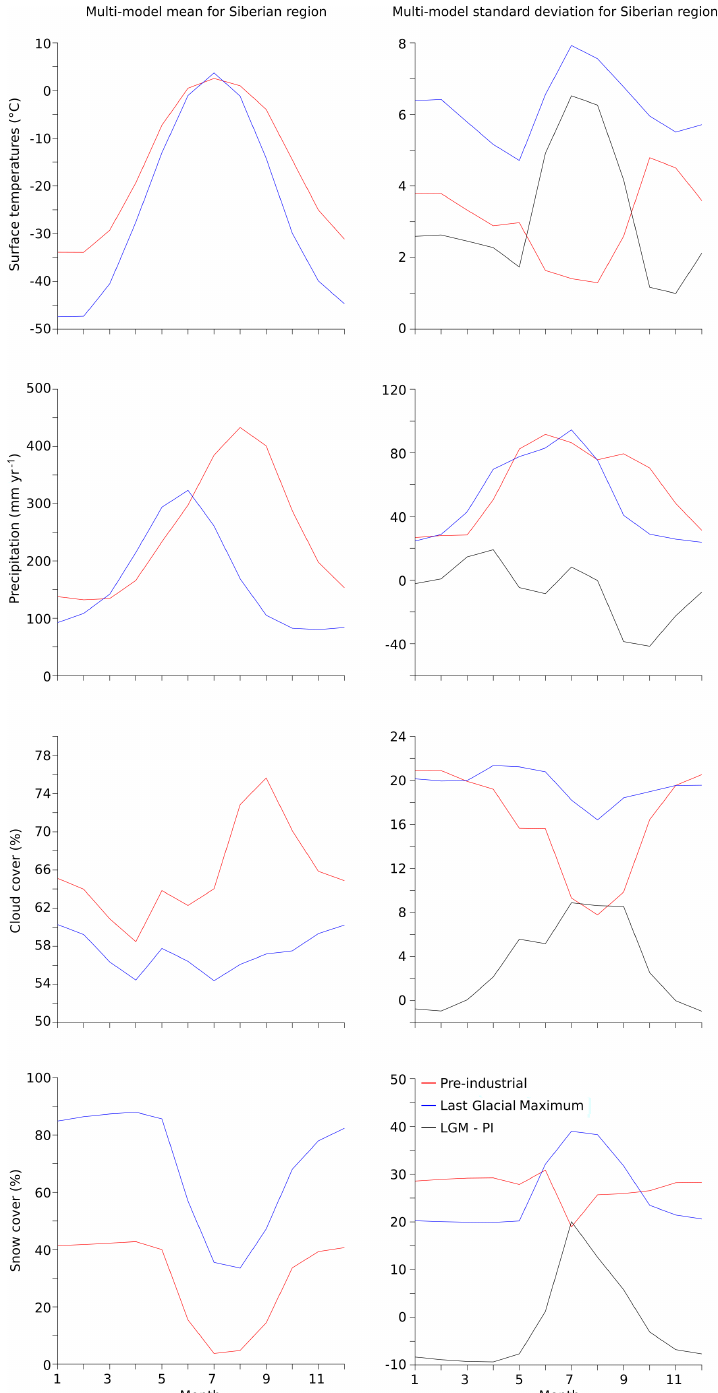
Figure A1. PMIP2 and PMIP3 multi-model mean (left panels) and multi-model standard deviation (right panels) seasonal cycles of selected variables for PI (red), LGM (blue), and LGM anomalies (LGM–PI; black). Mean and standard deviation are calculated for the Siberian target region. Top row: temperatures ( ◦ C); second row: precipitation (mmyr − 1 ); third row: cloud cover (%); bottom row: snow cover